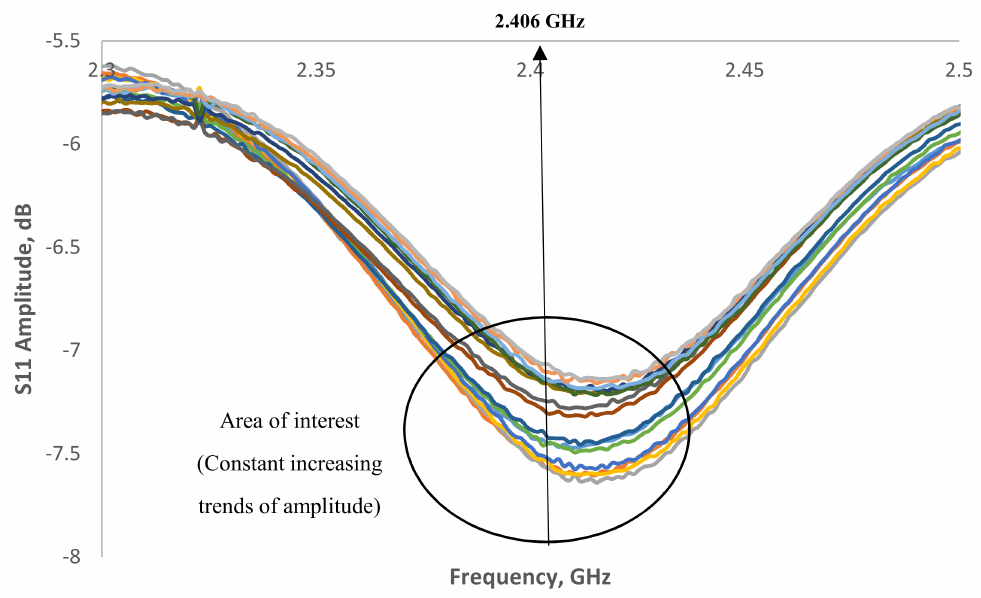
Figure 6. Signal spectrum for moisture content in MS 26-1-8:2010 concrete structure in the range of 2.3–2.5 GHz.